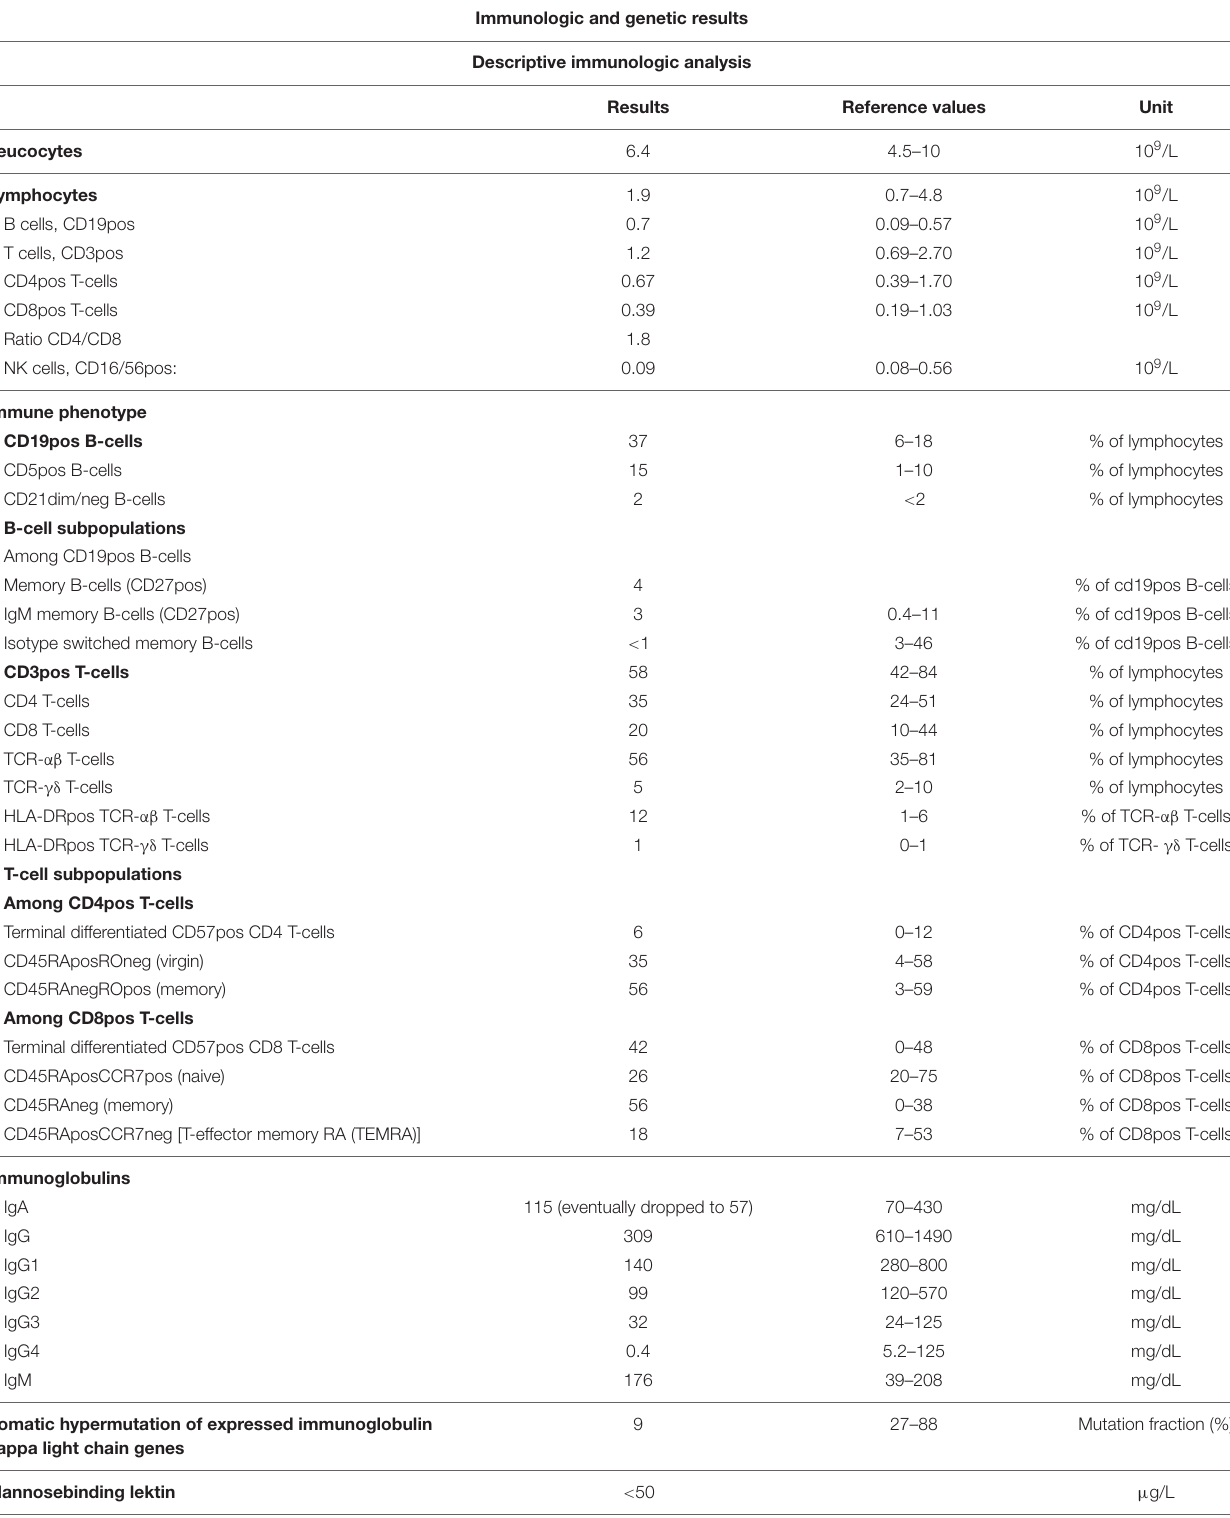
TABLE 1 | Results of immunological and genetic